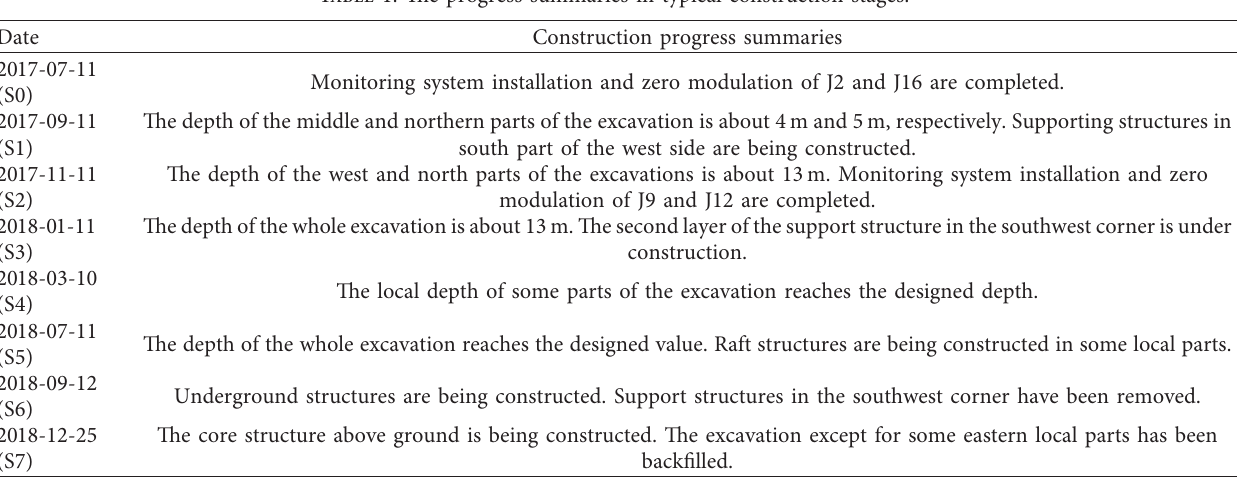
Figure 7: Dimensions and measured point distribution in the studied Table 1: The progress summaries in typical construction stages.